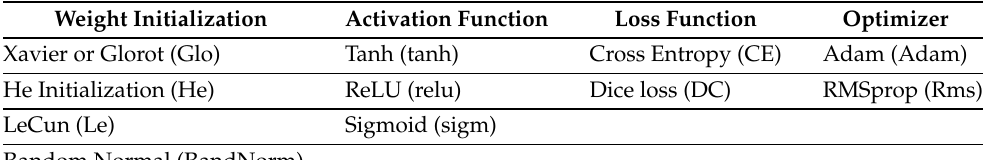
Table A1. Parameters experimented under each category, and their